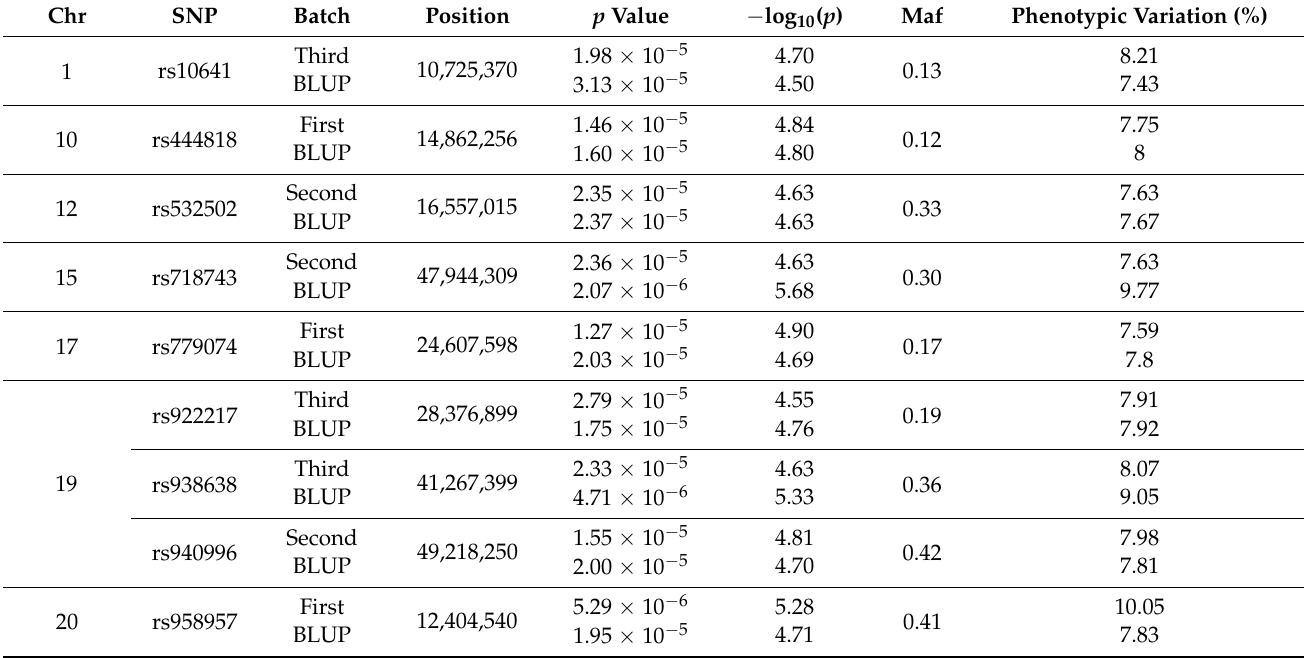
Table 5. The SNPs repeatedly associated with PRR.